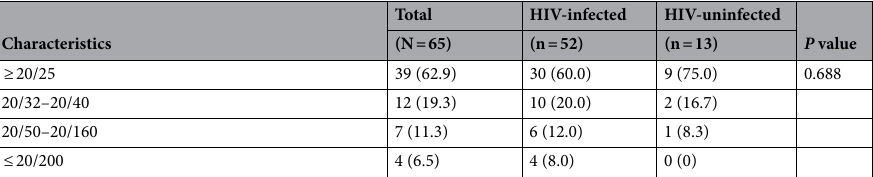
Table 2. Clinical characteristics of 65 eyes with syphilitic uveitis at presentation. a Calculated in 24 patients who underwent lumbar puncture. b Calculated in 62 eyes as three eyes were lost to follow-up before receiving antibiotic treatment. BCVA: best corrected visual acuity; SD: standard deviation; IOP: intraocular pressure; RPE: retinal pigment epithelium.